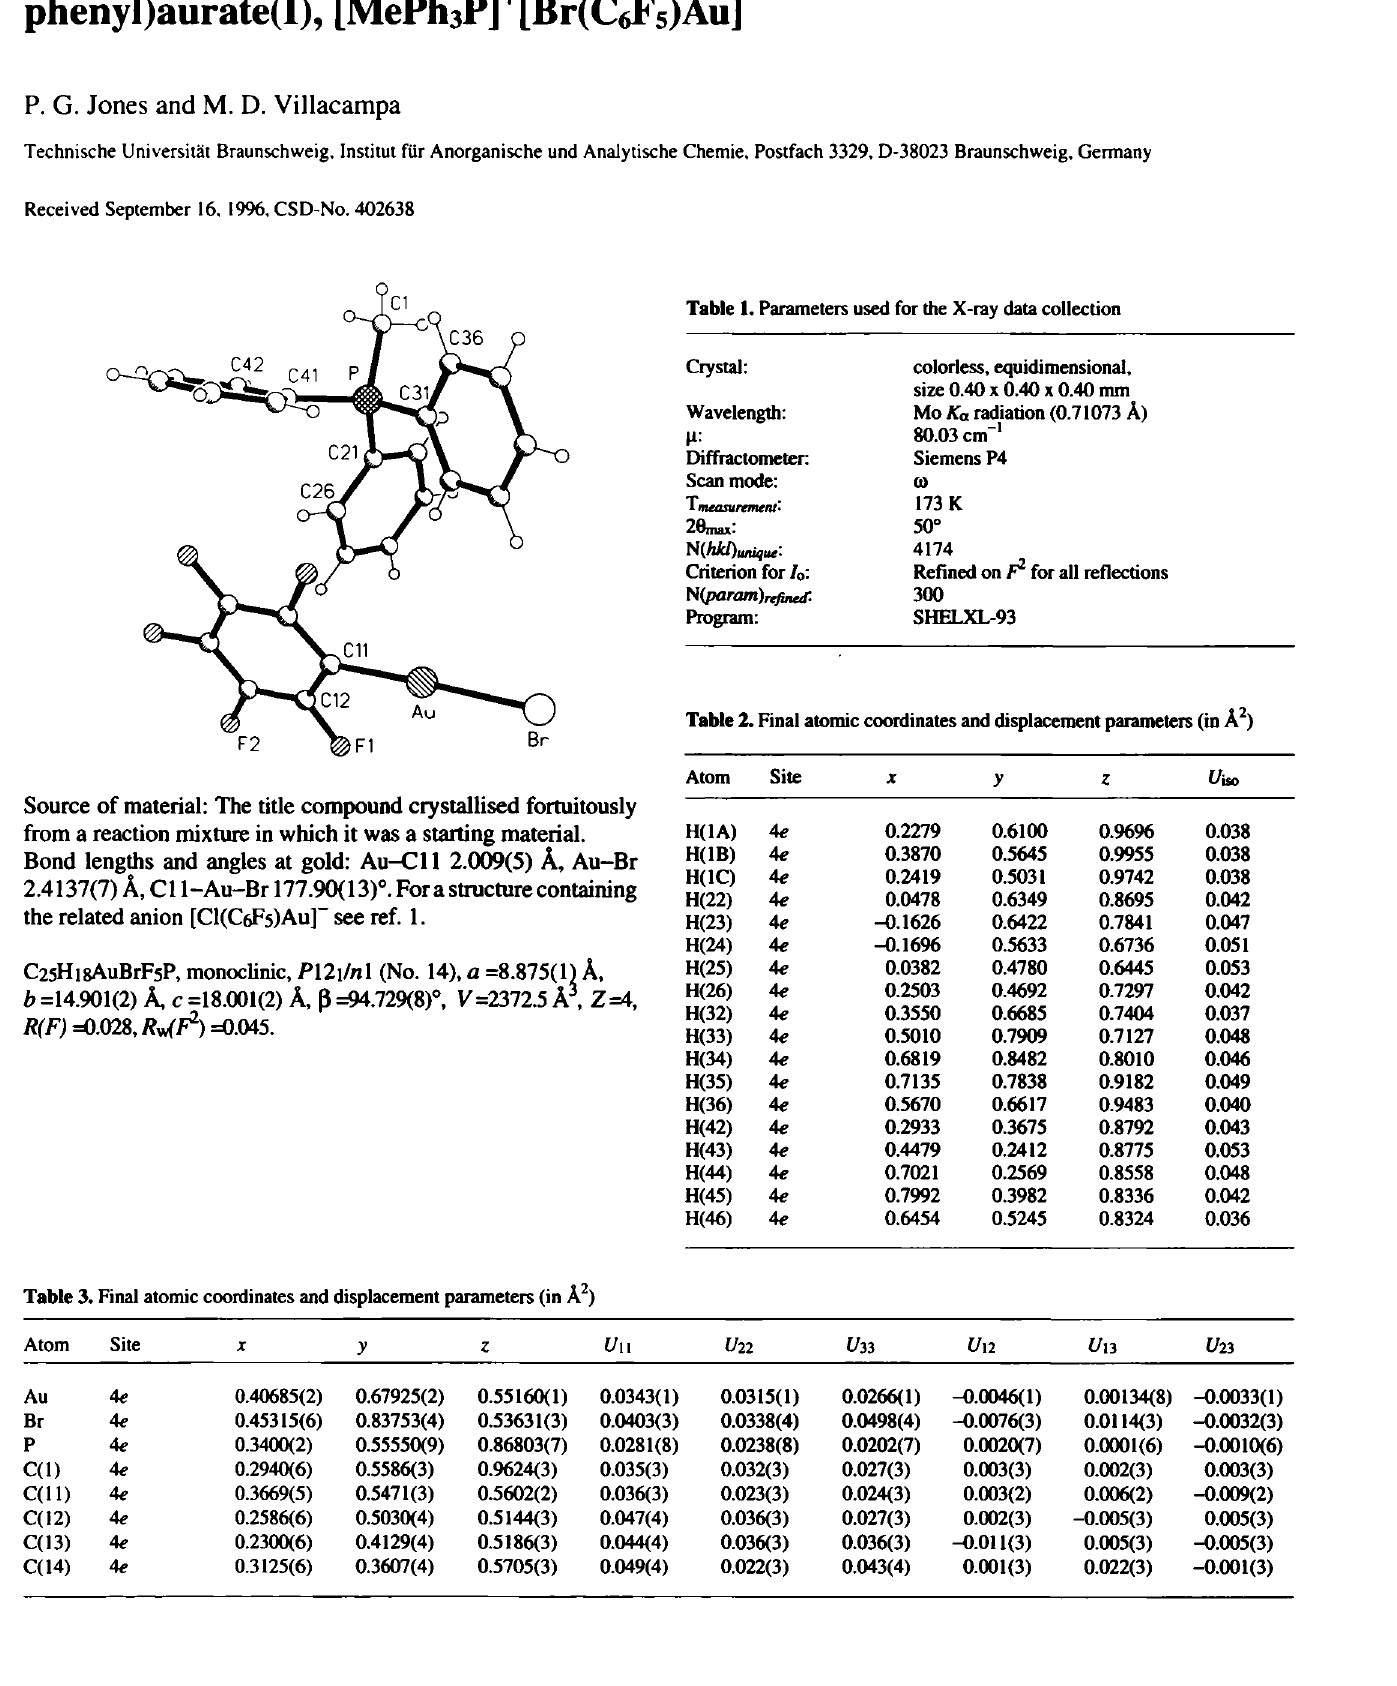
Table 1. Parameters used for the X-ray data collection